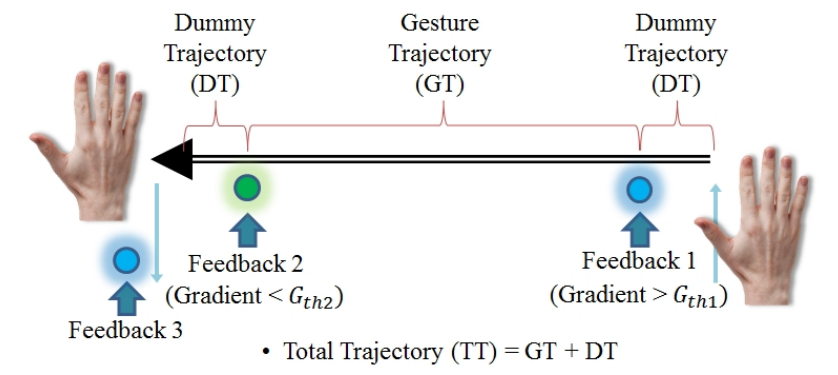
Figure 20. An example of gesture trajectories with the feedback locations in the right to left